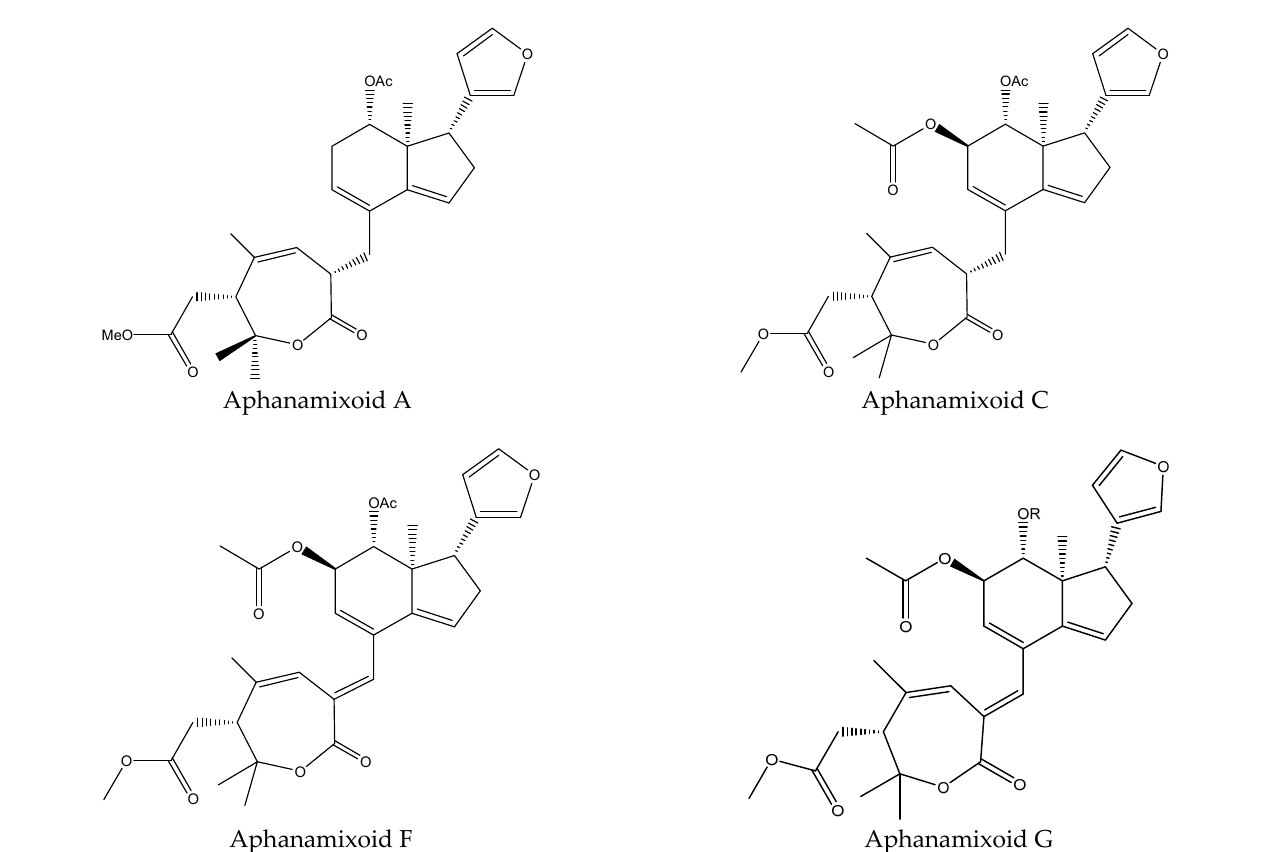
Figure 10. The structures of rings A,B-seco chemicals: prieurianins.